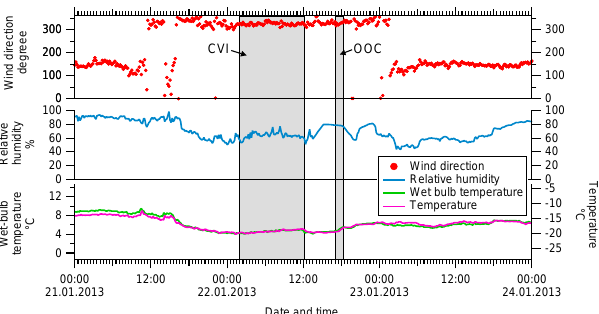
Figure 5. Wind direction, relative humidity, potential wet-bulb tem- perature and temperature (data from MeteoSwiss at the JFJ). The IPR sampling period is highlighted in blue, the out-of-cloud aerosol (OOC) sampling period in green.